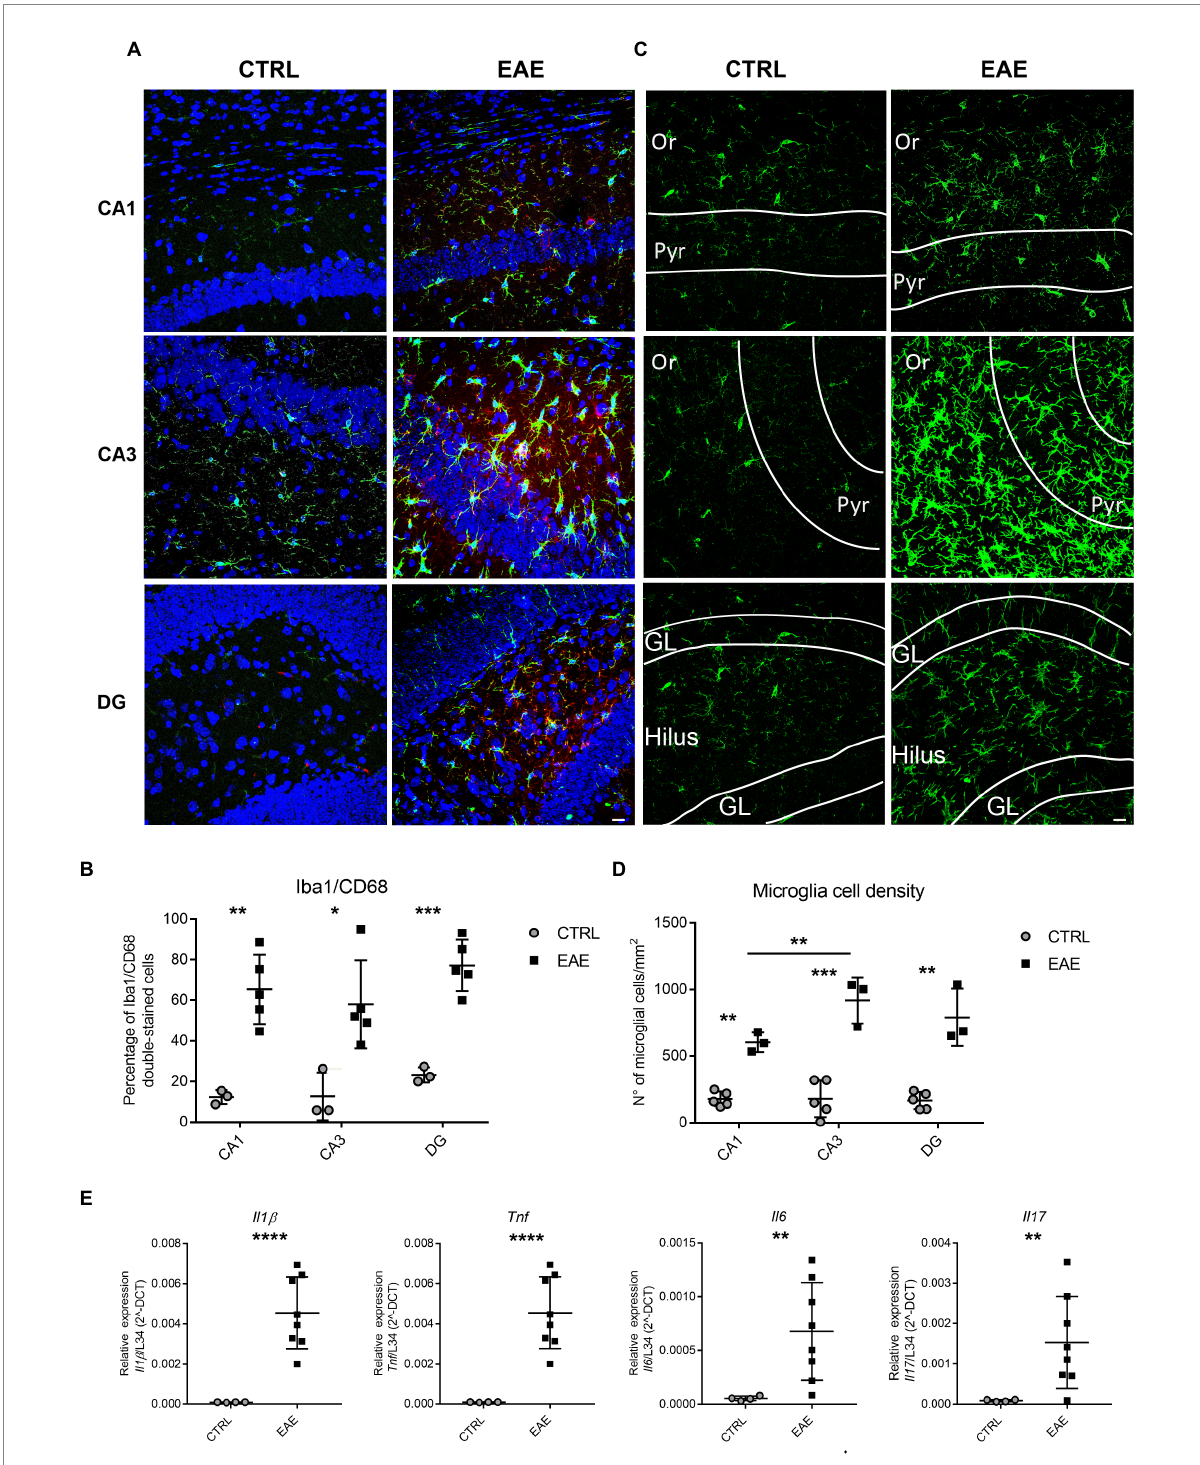
FIGURE 1 Experimental autoimmune encephalomyelitis (EAE) induces inflammatory changes in the hippocampus of EAE SJL/J mice at the beginning of the acute phase. (A) Representative confocal microscopy images of CA1, CA3 and DG hippocampal regions immunostained for the microglial marker Iba1 (green) and the microglial activation marker CD68 (red) and counterstained with Neurotrace (blue) from CTRL and EAE mice. EAE-animals show more numerous double-labelled Iba1/CD68 cells compared with CTRLs. Scale bar: 10 μ m. (B) Quantitative analysis shows a significantly higher percentage of Iba1/CD68 double-stained cells in all hippocampal regions of EAE animals compared with CTRLs (RM ANOVA: EAE factor: F 1-12 = 33.12, p = 0.0012; hippocampal region: F 2-12 = 3.9, p = 0.049; interaction: F 2-12 = 0.364, p = 0.7); Student’s t test: CA1 ** p = 0.0021, CA3 * p = 0.017, DG *** p = 0.0004). (C) Representative micrographs of Iba1+ hippocampal sections from CTRL and EAE mice pointing out an increase